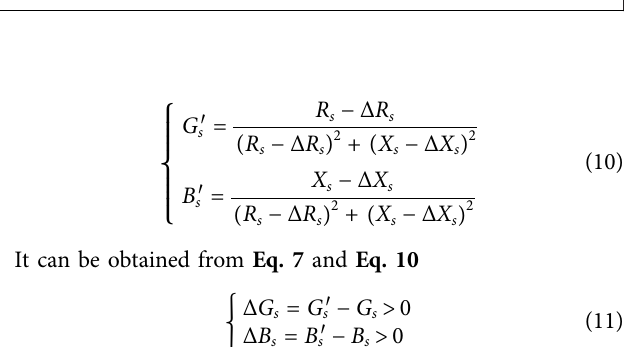
FIGURE 5 | Exposed area under different DG penetration rate.